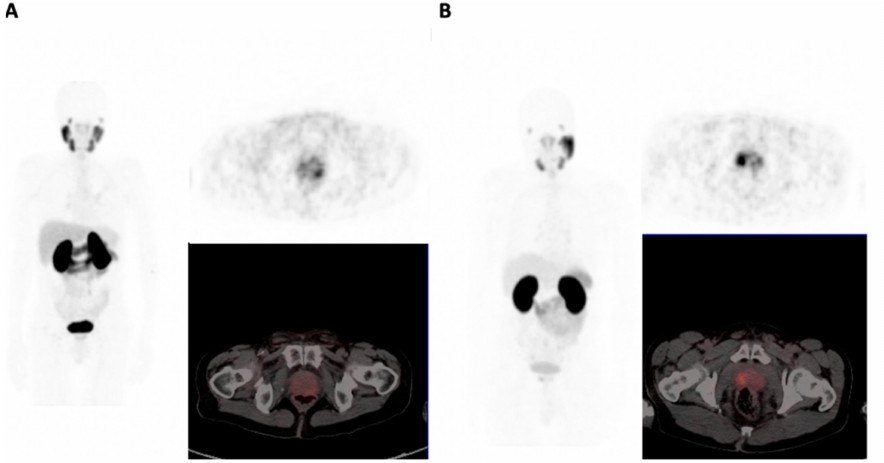
Figure 2. Comparison of primary tumor PSMA-TV in WSA ( A ) and BSA ( B ) for two patients with GG 1 disease in maximum projection image, PET only and fused PET/CT. ( A ) corresponds to a 61-year- old WSA with PSA 73.31 ug/L. SUVmax–3.42, TL-PSMA–0.90, PSMA-TV of 0.29. ( B ) corresponds to a 60-year-old BSA with PSA of 22 ug/L. SUVmax–6.85, TL-PSMA–17.3,